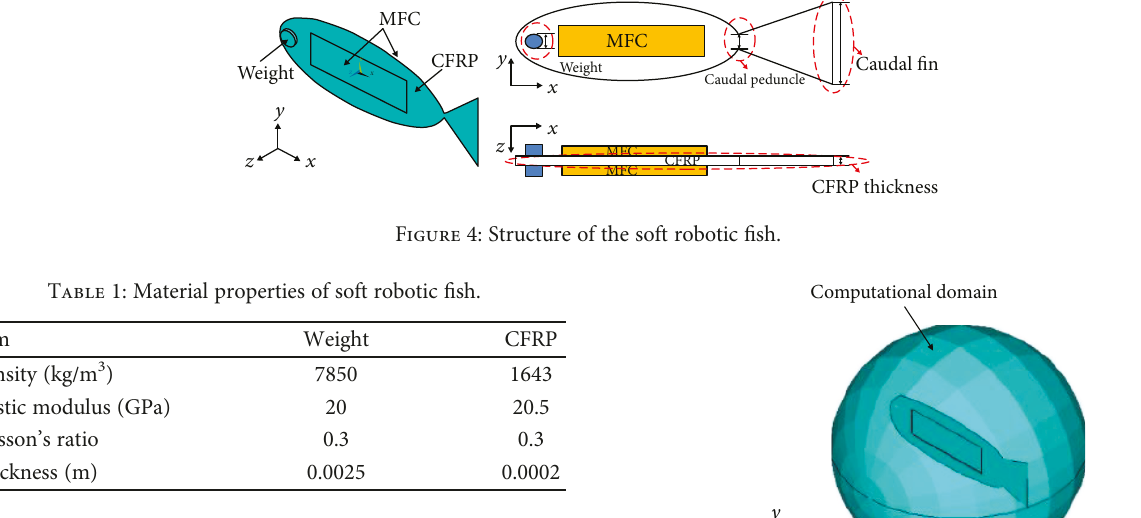
Table 2: Range of key structural parameters of the soft robot. Key structural parameters of soft robot